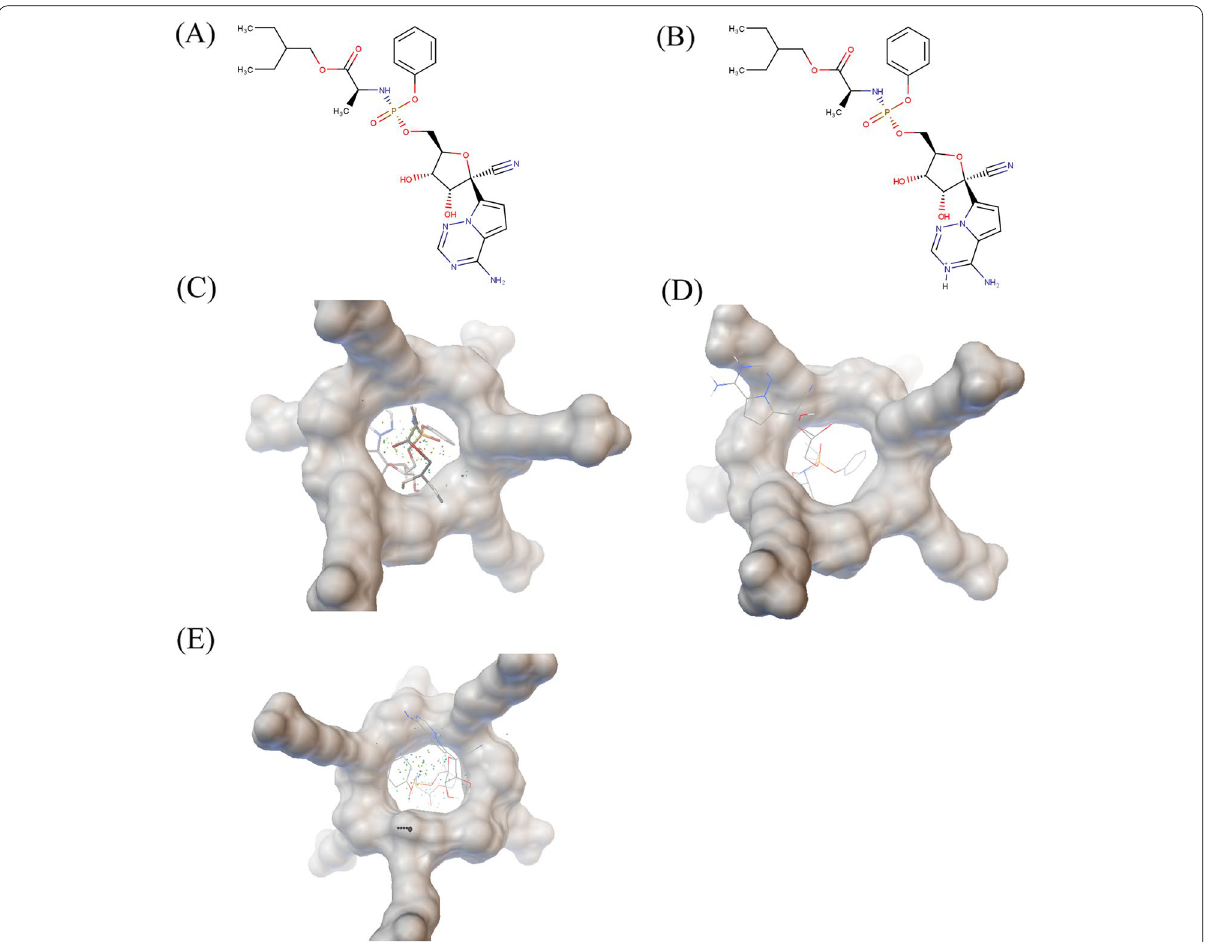
Fig. 3 Docking poses of neutral RDV and RDV Cation1: ( A ) structure of neutral RDV; ( B ) structure of RDV Cation A; ( C ) docking pose of neutral RDV; ( D ) docking pose of RDV Cation A; ( E ) docking pose of RDV Cation B. The small dots in the docking poses represent the locations of the first 50 most stable poses during